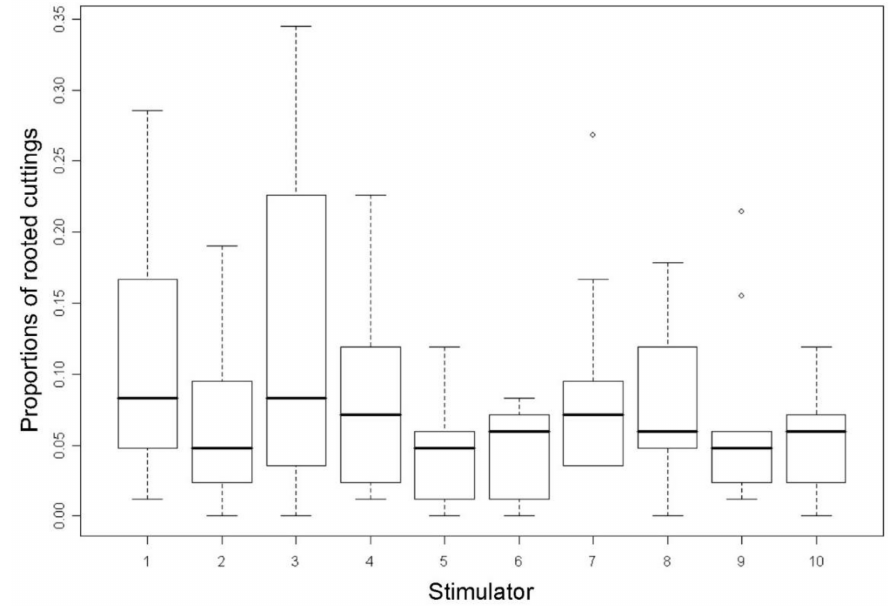
Figure 2. Box plot for the proportion of rooted cuttings of the total number of cuttings in relation to the stimulator (1–10, see Section 2.1). The horizontal line in each box represents the median, the hinges represent the 25th and 75th percentiles, the whiskers represent 1.5 times the interquartile range and open circles represent values outside this